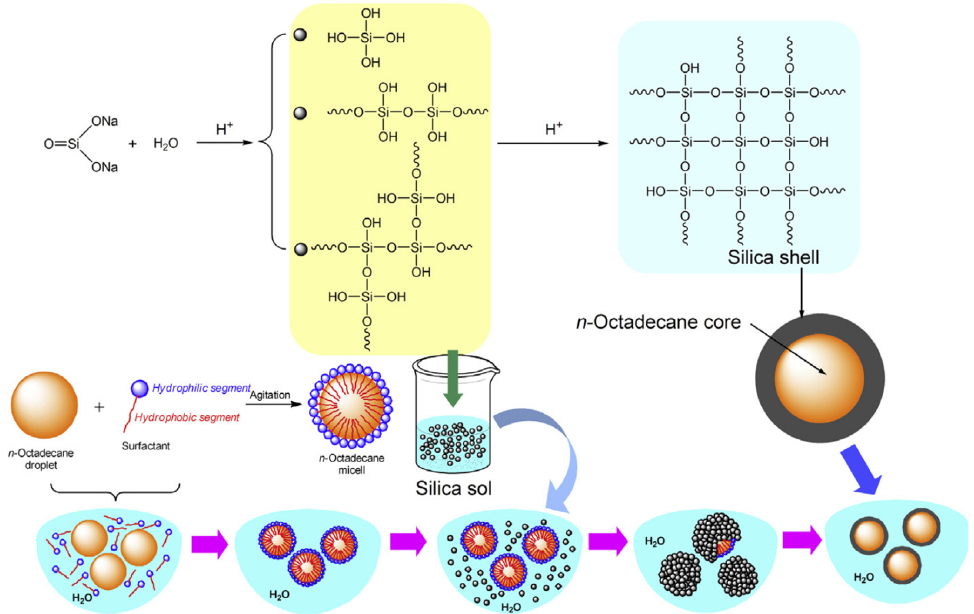
Figure 10. Sol-gel method: Obtaining microencapsulated n-octadecane with silica wall using sodium silicate as precursor [117]. Reproduced with permission from Elsevier.